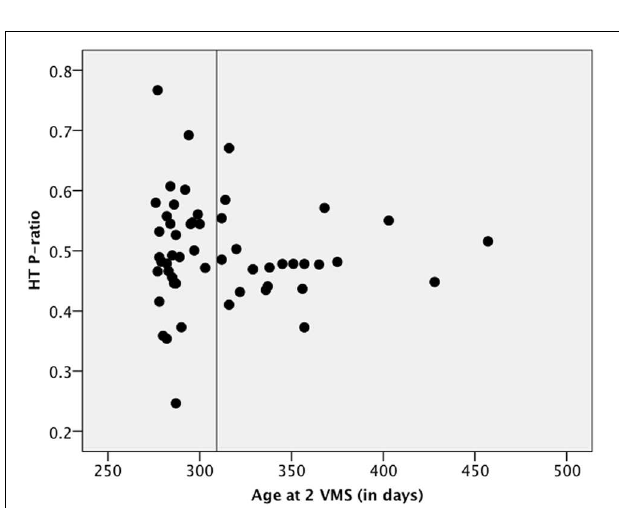
FIGURE 3 | The average growth on the CDI by response on the AHPP (low, mid, and high preference ratio infants).